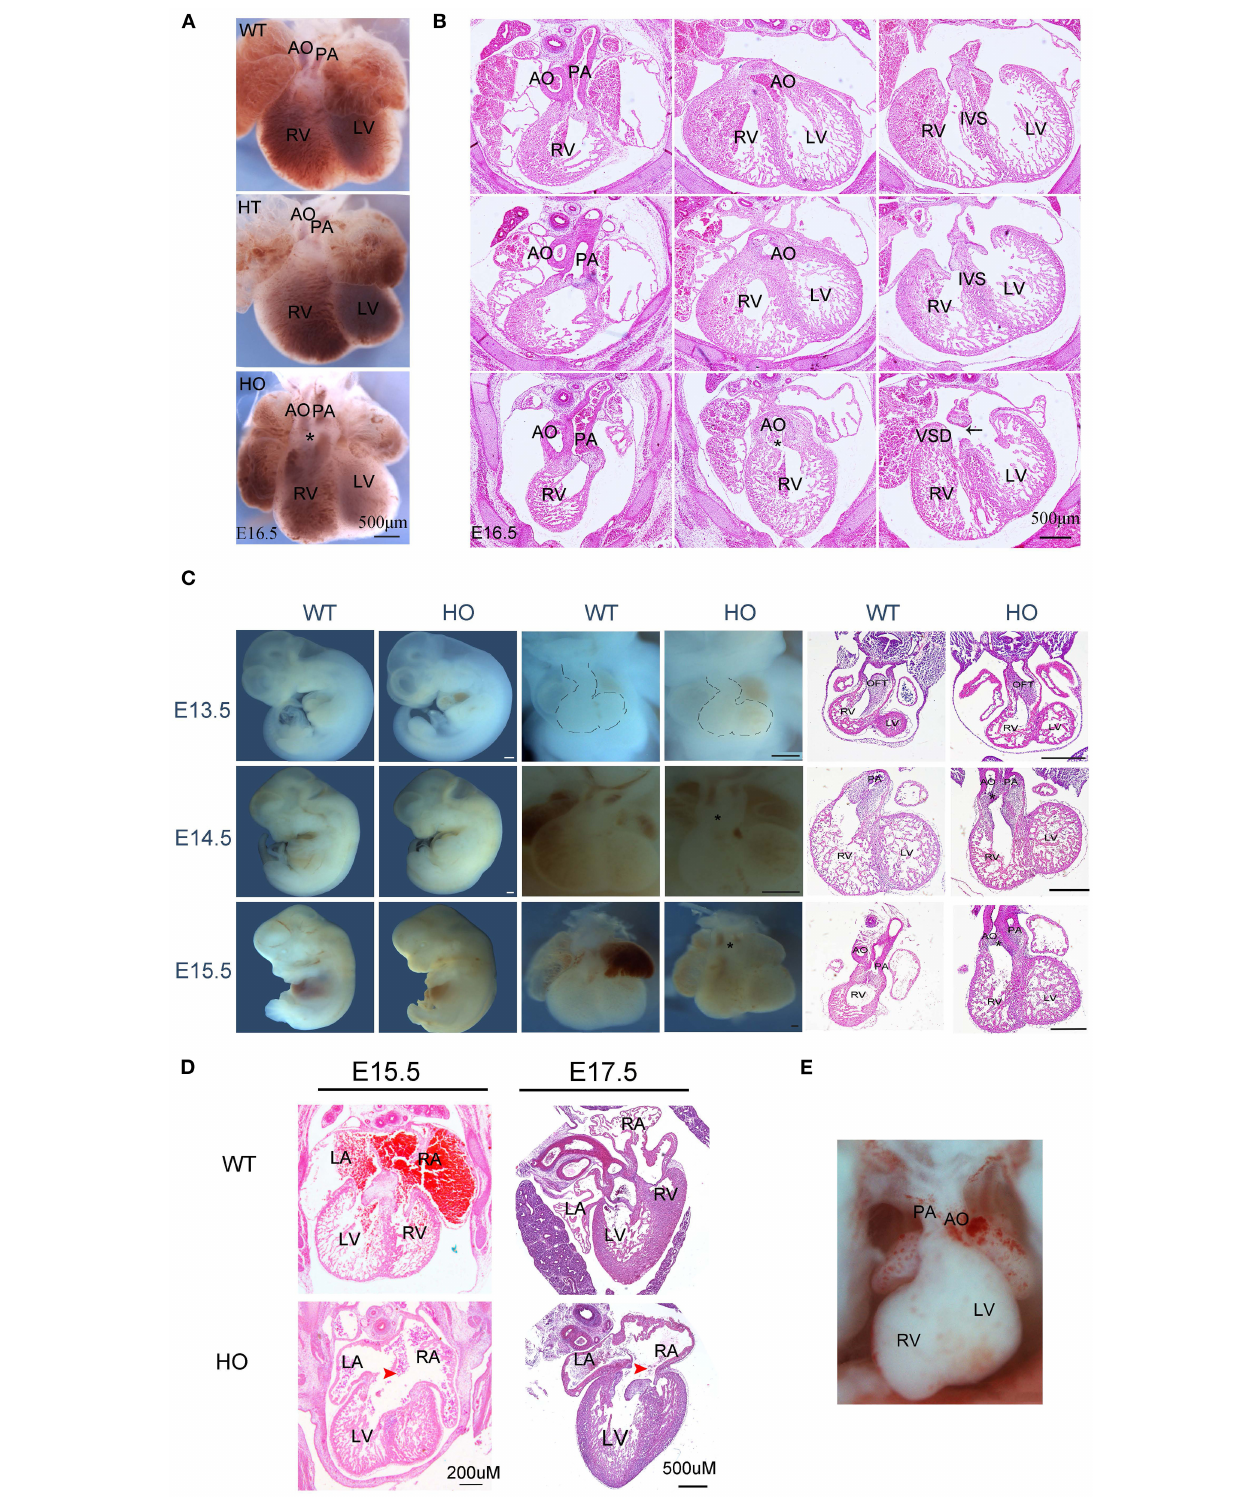
FIGURE 3 | SNX17-null rats exhibit severe cardiac defects. (A,B) Representive images of the ventral heart and corresponding H&E sections from WT, HT, and HO embryos at E16.5 (black arrow, VSD). (C) Embryo morphology, heart, and H&E sections at E13.5 to E15.5 (*, DORV; all scale bar, 500 µ M). (D) H&E staining images of AVSD defect from embryos at E15.5 and E17.5. (E) The DOLV defect image. AO, aorta; PA, pulmonary artery; RV, right ventricle; LV, left ventricle; LA, left atrium; RA, right atrium; IVS, interventricular septum; VSD, ventricular septal defect; DORV, double-outlet RV; DOLV, double-outlet LV.